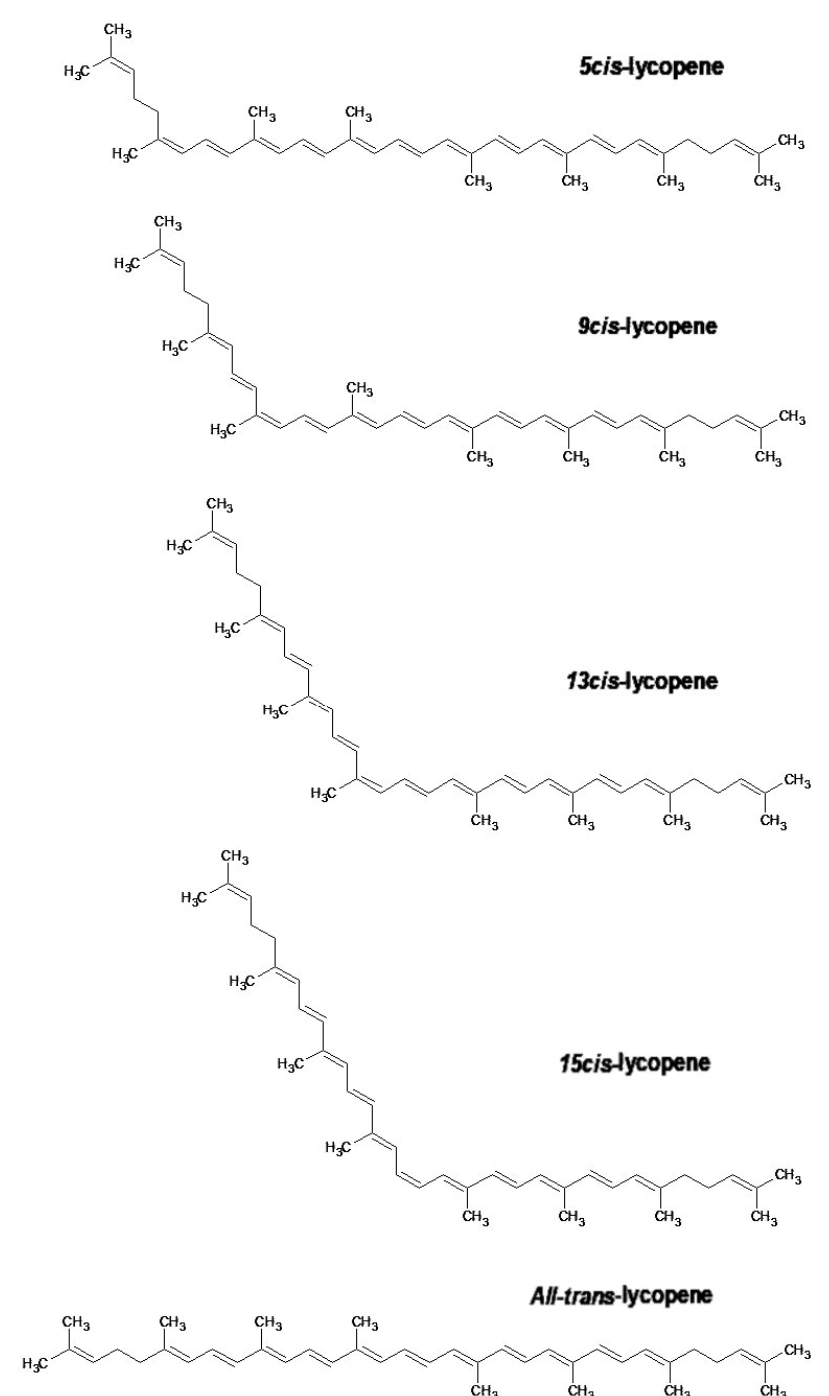
Figure 2. Representation of cis and trans- lycopene structure. Data deposited in computer by Pub- Chem [14] and converted to 2D with ACD/Labs [15].